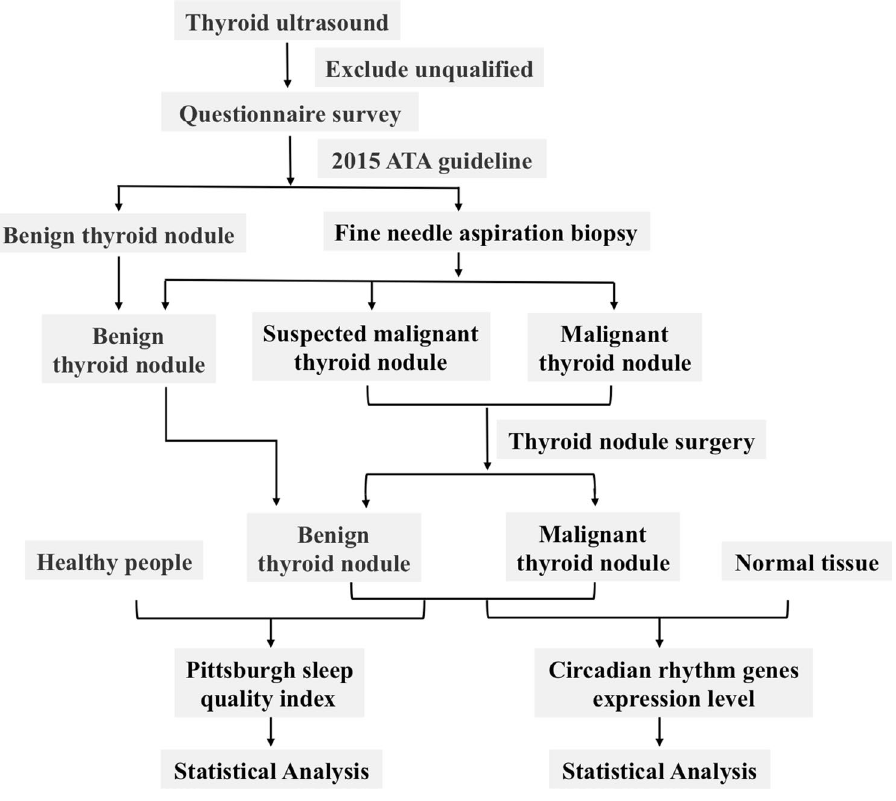
Figure 1. The whole processes of our